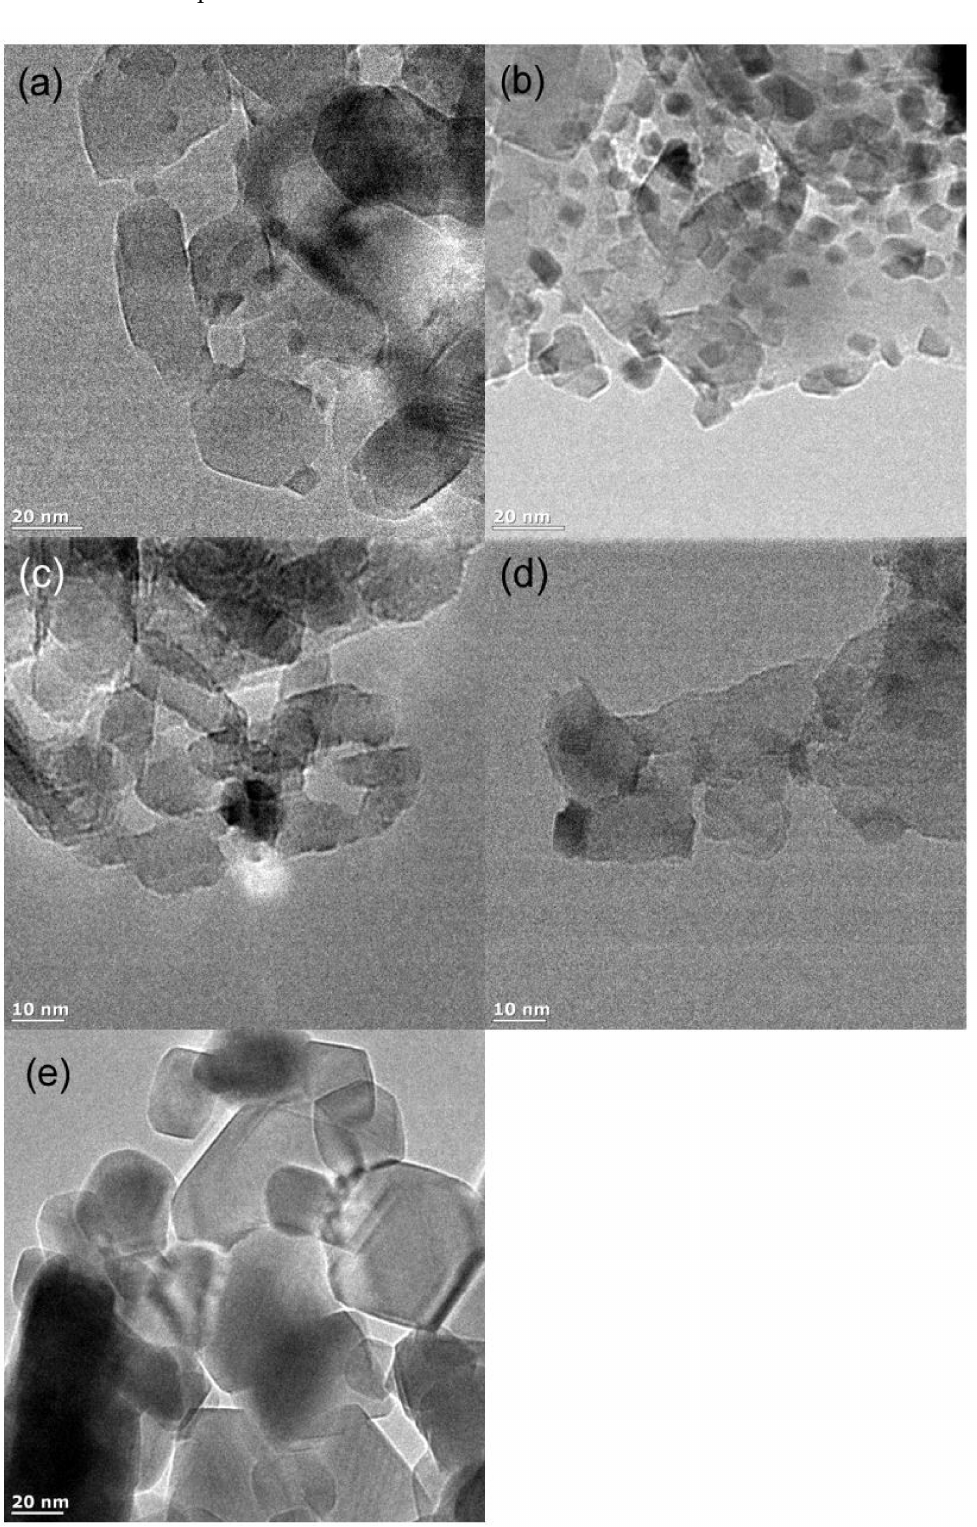
Figure 2. TEM images of ( a ) 0.01-CeO 2 /MgO(air), ( b ) 0.05-CeO 2 /MgO(air), ( c ) 0.01-CeO 2 /MgO(dry), ( d ) 0.05-CeO 2 /MgO(dry), and ( e ) CeO 2 . STEM-EDS of the samples are shown in Figure